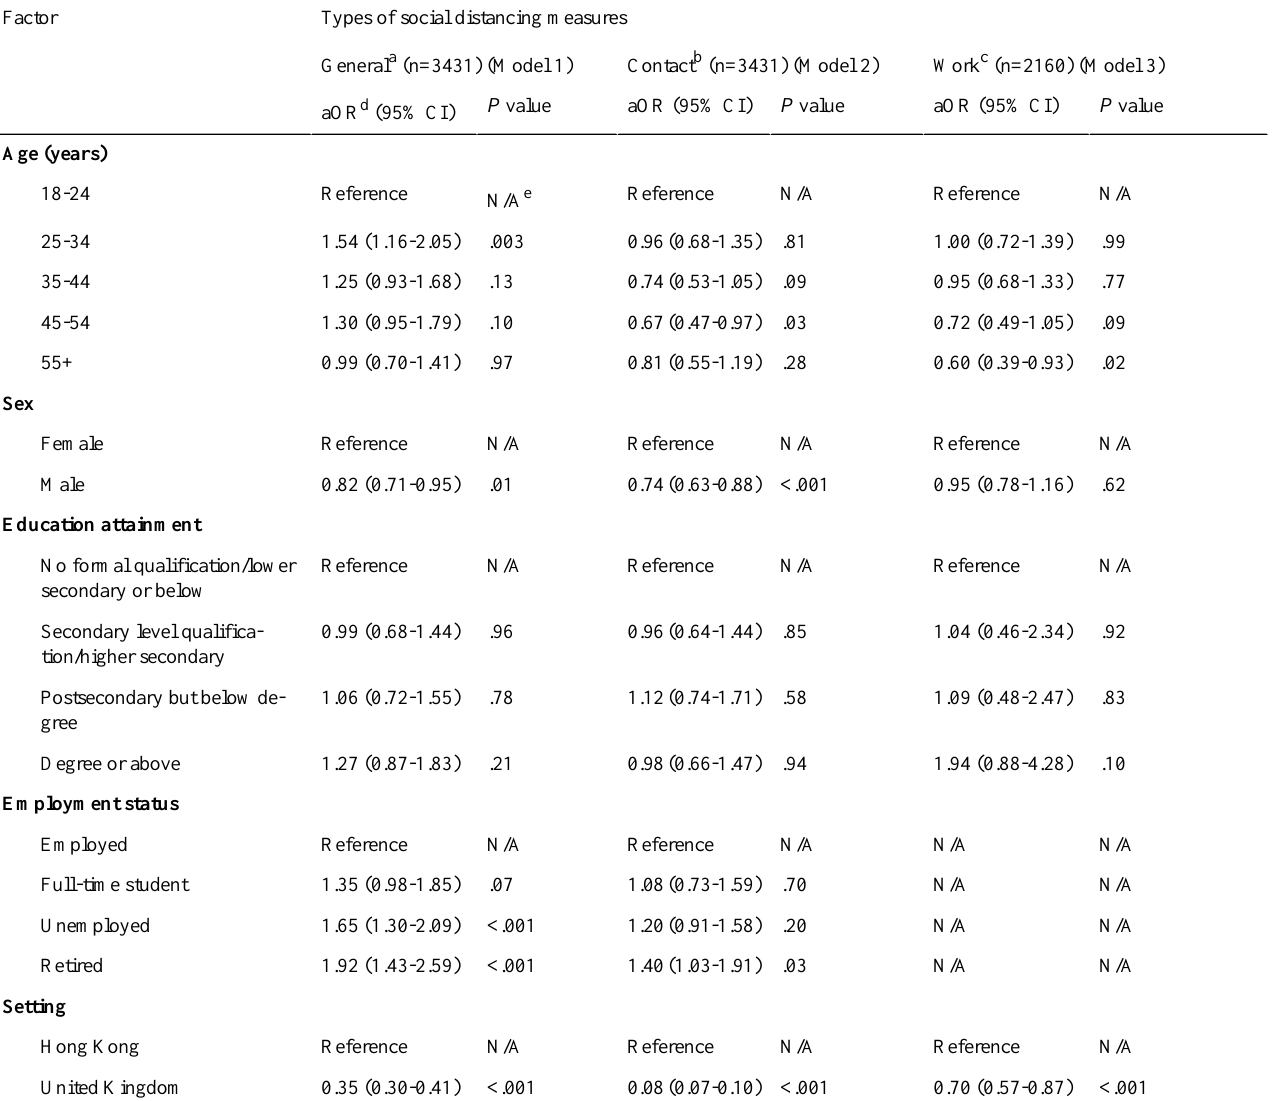
Table 3. Factors associated with the adoption of different social distancing measures. Types of social distancing